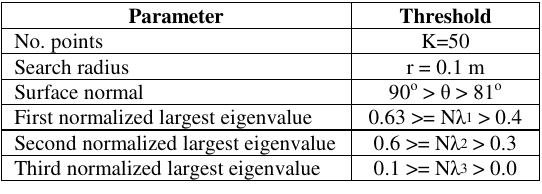
Table 1. Thresholds of different parameters-second phase.